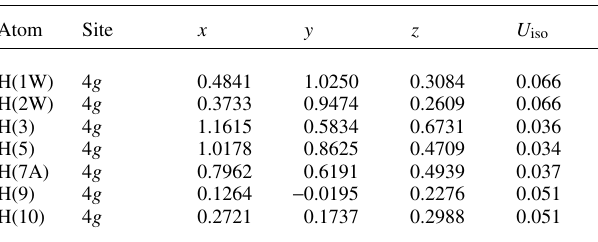
Table 3. Atomic coordinates and displacement parameters (in Å 2 ) .